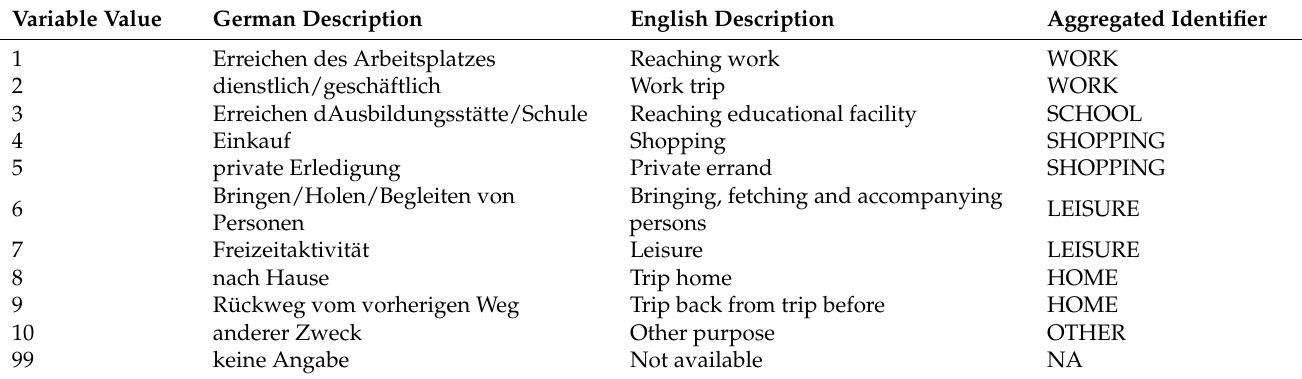
Table A4. Trip purpose descriptions in the data set MiD2017 and respective mappings to VencoPy internal trip categories.